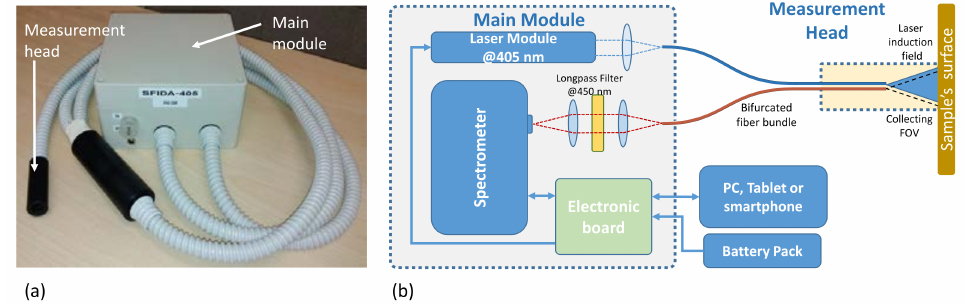
Figure 1. SFIDA–405 prototype: ( a ) main module and measurement head and ( b ) block